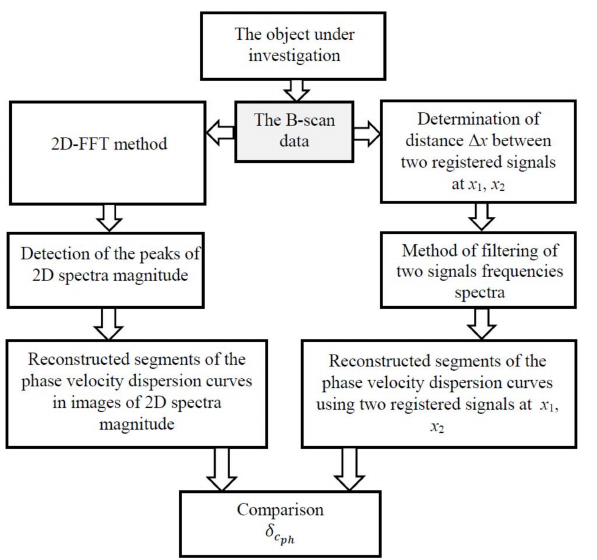
Figure 1. A general scheme of the test procedure for a dispersion curve reconstruction algorithm based on signals measured at two different